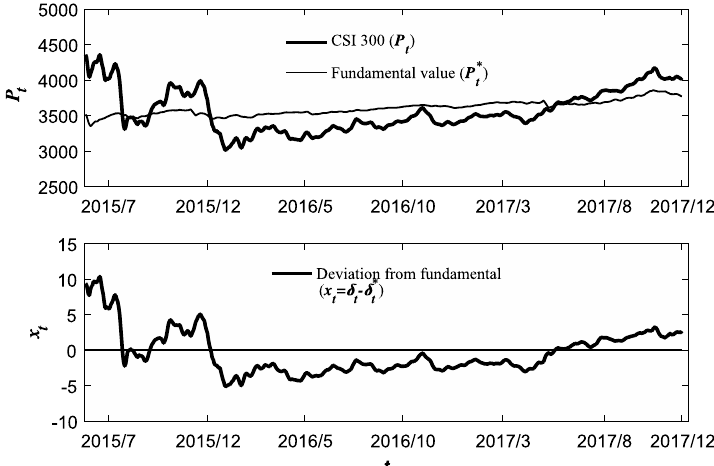
Fig. 3 CSI 300 with its fundamental value, corrected for inflation (top panel), and the deviation from the fundamental value (bottom